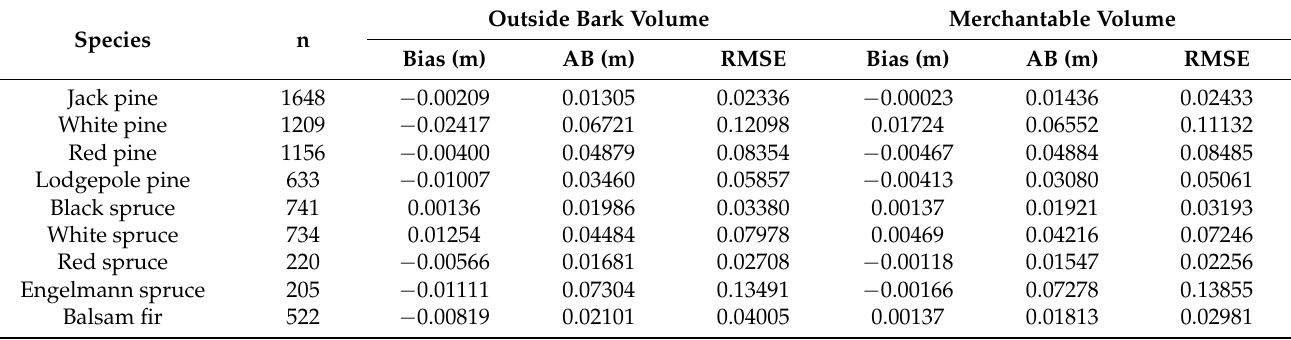
Table 6. Mean bias (observed − predicted), absolute mean bias (AB), and root mean square error (RMSE) of the residuals for outside bark and merchantable volumes using Equation (10) for 25 tree species grown in Canada and the northeastern United